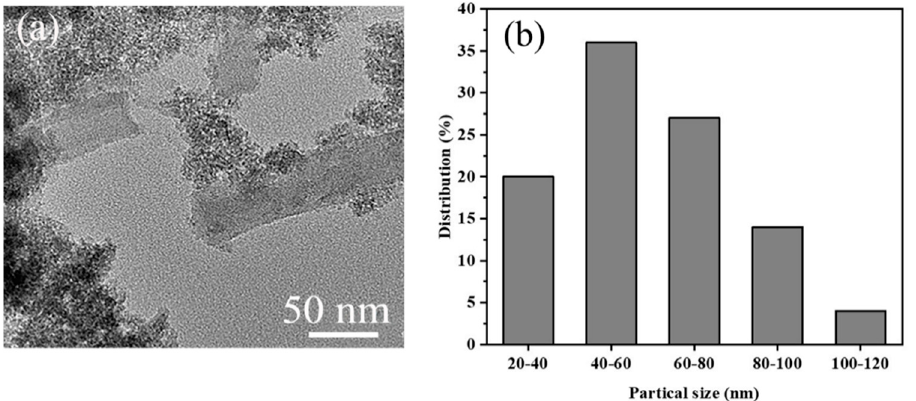
Figure 4. TEM image ( a ) and particle size distribution ( b ) of MCS .